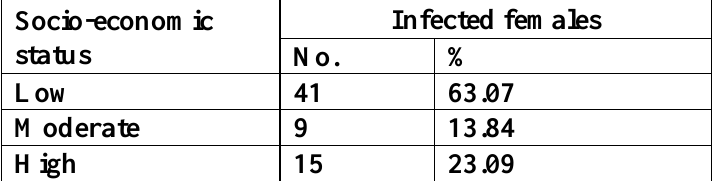
Table (6): Relation between T. Vaginalis infection and socio-economic status.